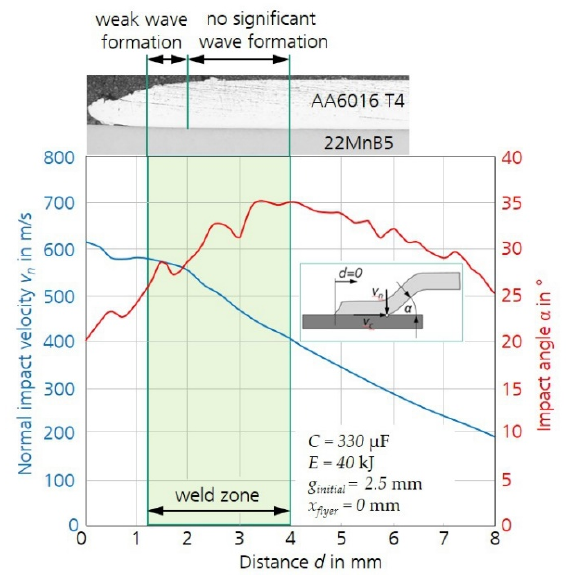
Figure 5. Comparison of the collision parameter distribution for a high-quality welding sample (condition 1).